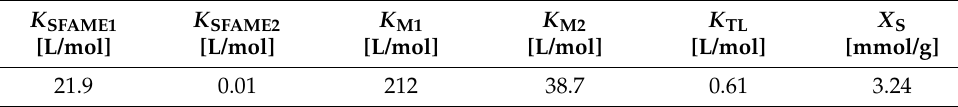
Table 2. Estimated adsorption equilibrium constants.